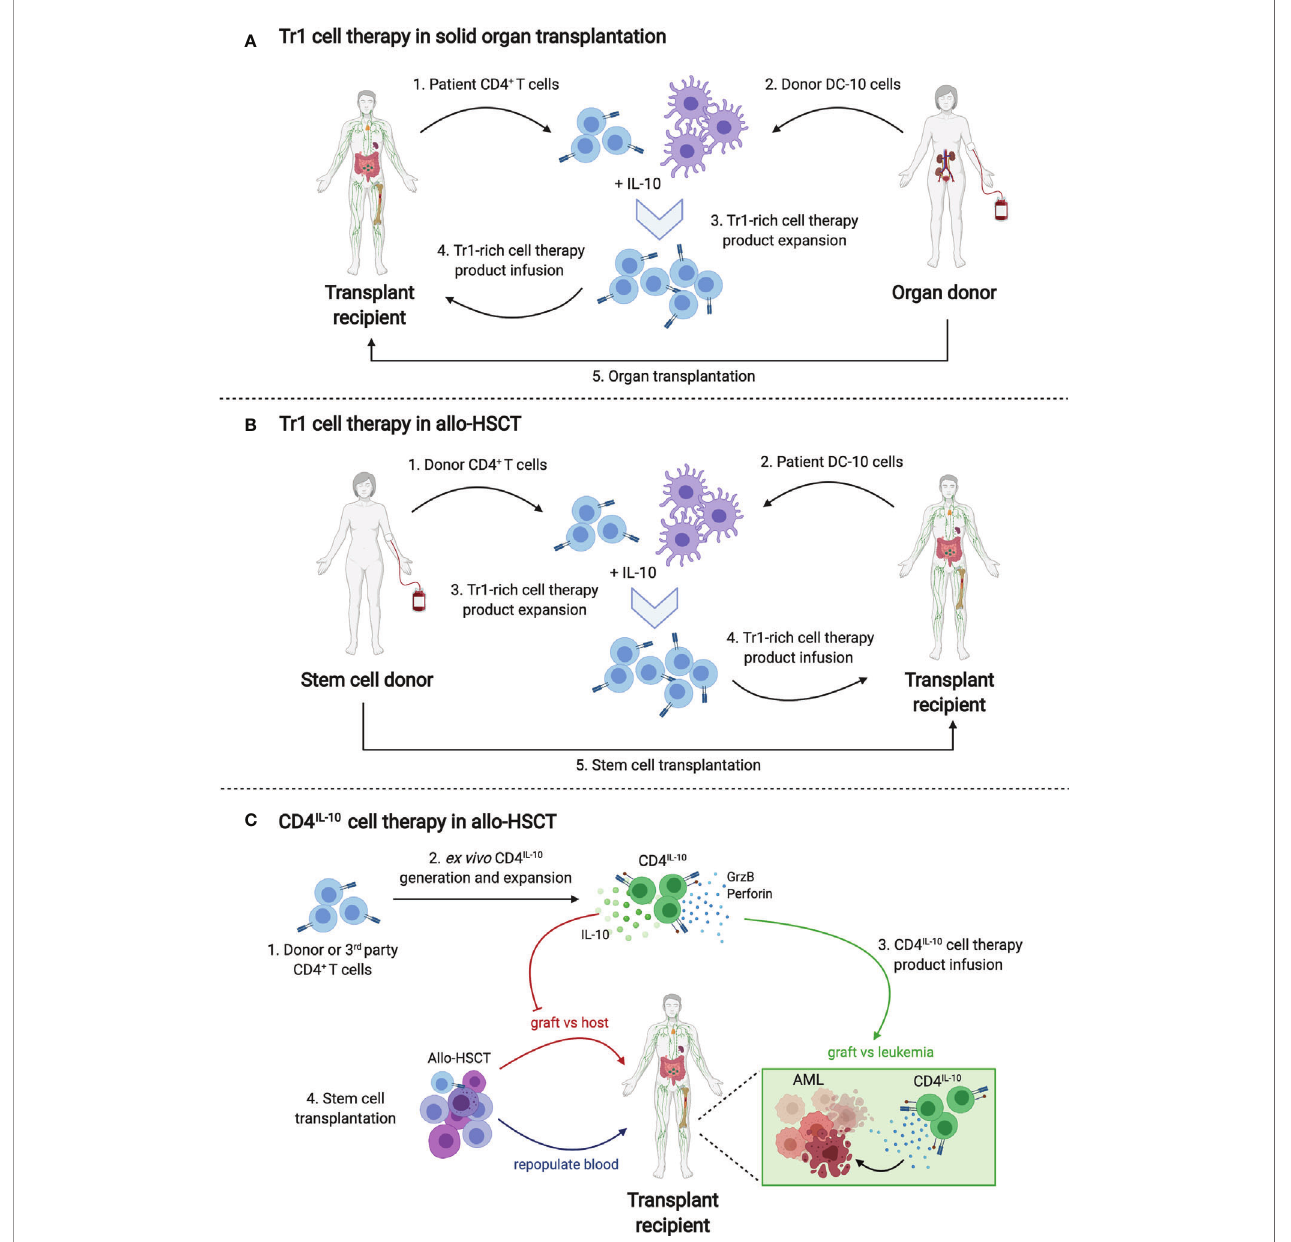
FIGURE 1 | Tr1 cell therapy strategies in transplantation. (A) Tr1 cell therapy in solid organ transplantation. Patient CD4 + T cells (1) and donor tolerogenic DC- 10 cells (2) will be isolated prior to organ transplantation. A Tr1-rich cell therapy product will be expanded by culturing CD4 + T cells and DC-10 in the presence of exogenous IL-10 (3). The alloantigen-speci fi c Tr1-rich cell therapy product will be phenotyped and tested ex vivo for suppressive capacity and will be infused into the transplant recipient (4). Concurrently or a day after infusion, organ transplantation will take place (5). (B) Tr1 cell therapy in allo-HSCT. Donor CD4 + T cells (1) and patient-derived tolerogenic DC-10 cells (2) will be isolated prior to HSCT. Steps (3) and (4) will be followed as in part (A) . A day after infusion, HSCT will take place (5). (C) CD4 IL-10 cell therapy in allo-HSCT. In this example, the transplant recipient is an acute myeloid leukemia patient. Stem cell donor or 3 rd party healthy donor CD4 + T cells will be isolated (1) and transduced with hIL10 lentivirus to generate CD4 IL-10 cells (2). After ex vivo expansion and quality control, CD4 IL-10 cells will be infused to the transplant recipient (3) concurrently with allo-HSCT (4). While donor stem cells repopulate blood, donor T cells promote graft versus host disease (GvHD). CD4 IL-10 cells prevent GvHD by secretion of IL-10 and promote graft versus leukemia (GvL) response via granzyme B/perforin mediated cytotoxicity against residual AML